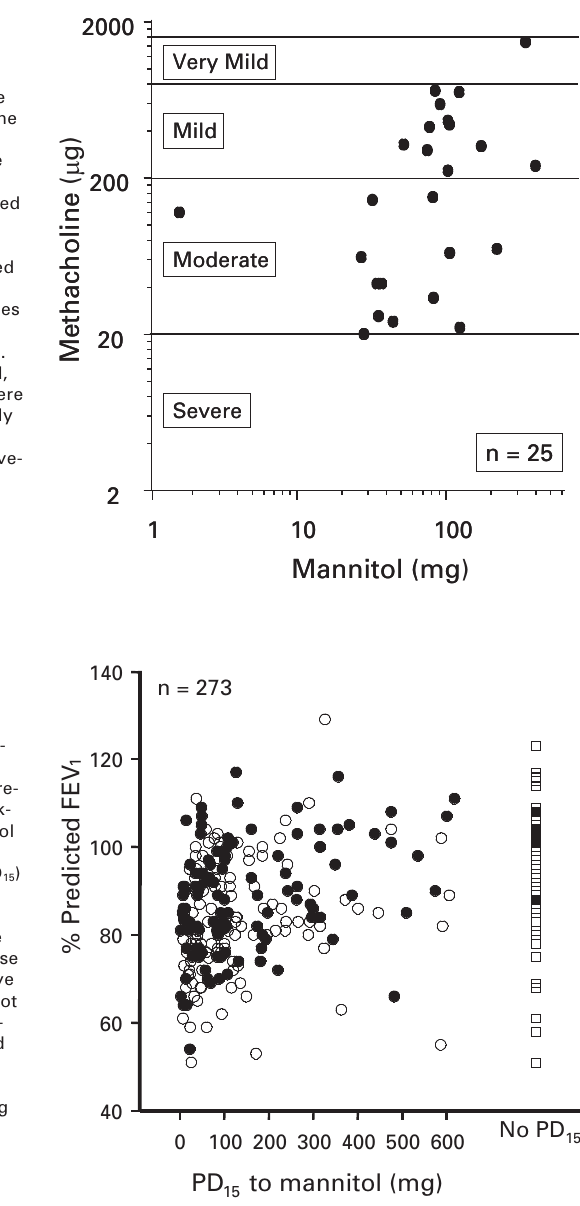
Forced expiratory volume in one sec- ond (FEV 1 ) as a per- centage of the pre- dicted value [2] in re- lation to the provok- ing dose of mannitol to cause a 15% re- duction in FEV 1 (PD 15 ) for 273 asthmatic subjects who per- formed a challenge with mannitol. Those responsive (i.e. have a PD 15 ) who were not taking ICS are illus- trated as the closed circles (rp = 0.35, n = 112), those re- sponsive and taking ICS as the open circles (rp = 0.27, n = 117). Those 44 subjects who were not responsive to mannitol (i.e., No PD 15 ) and taking ICS are illustrated as open squares, and those not responsive and not taking ICS as closed